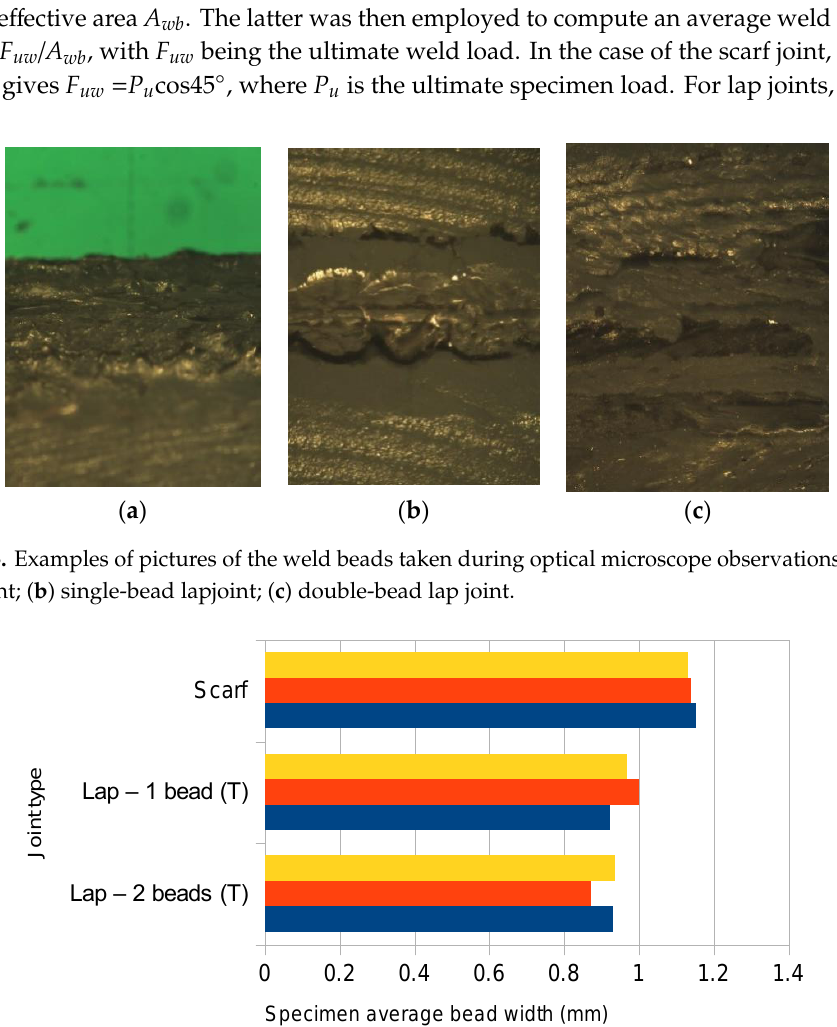
Figure 6. Average weld bead widths of the specimens tested.